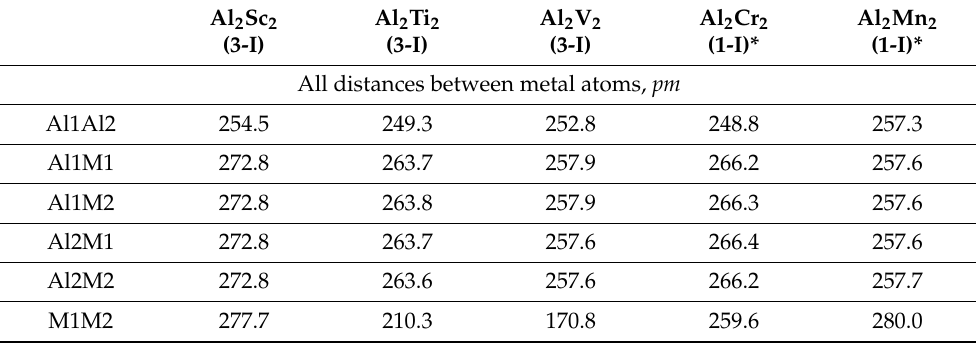
Table 2. Structural parameters of most stable Al 2 M 2 metal clusters (M = Sc, Ti, V, Cr,